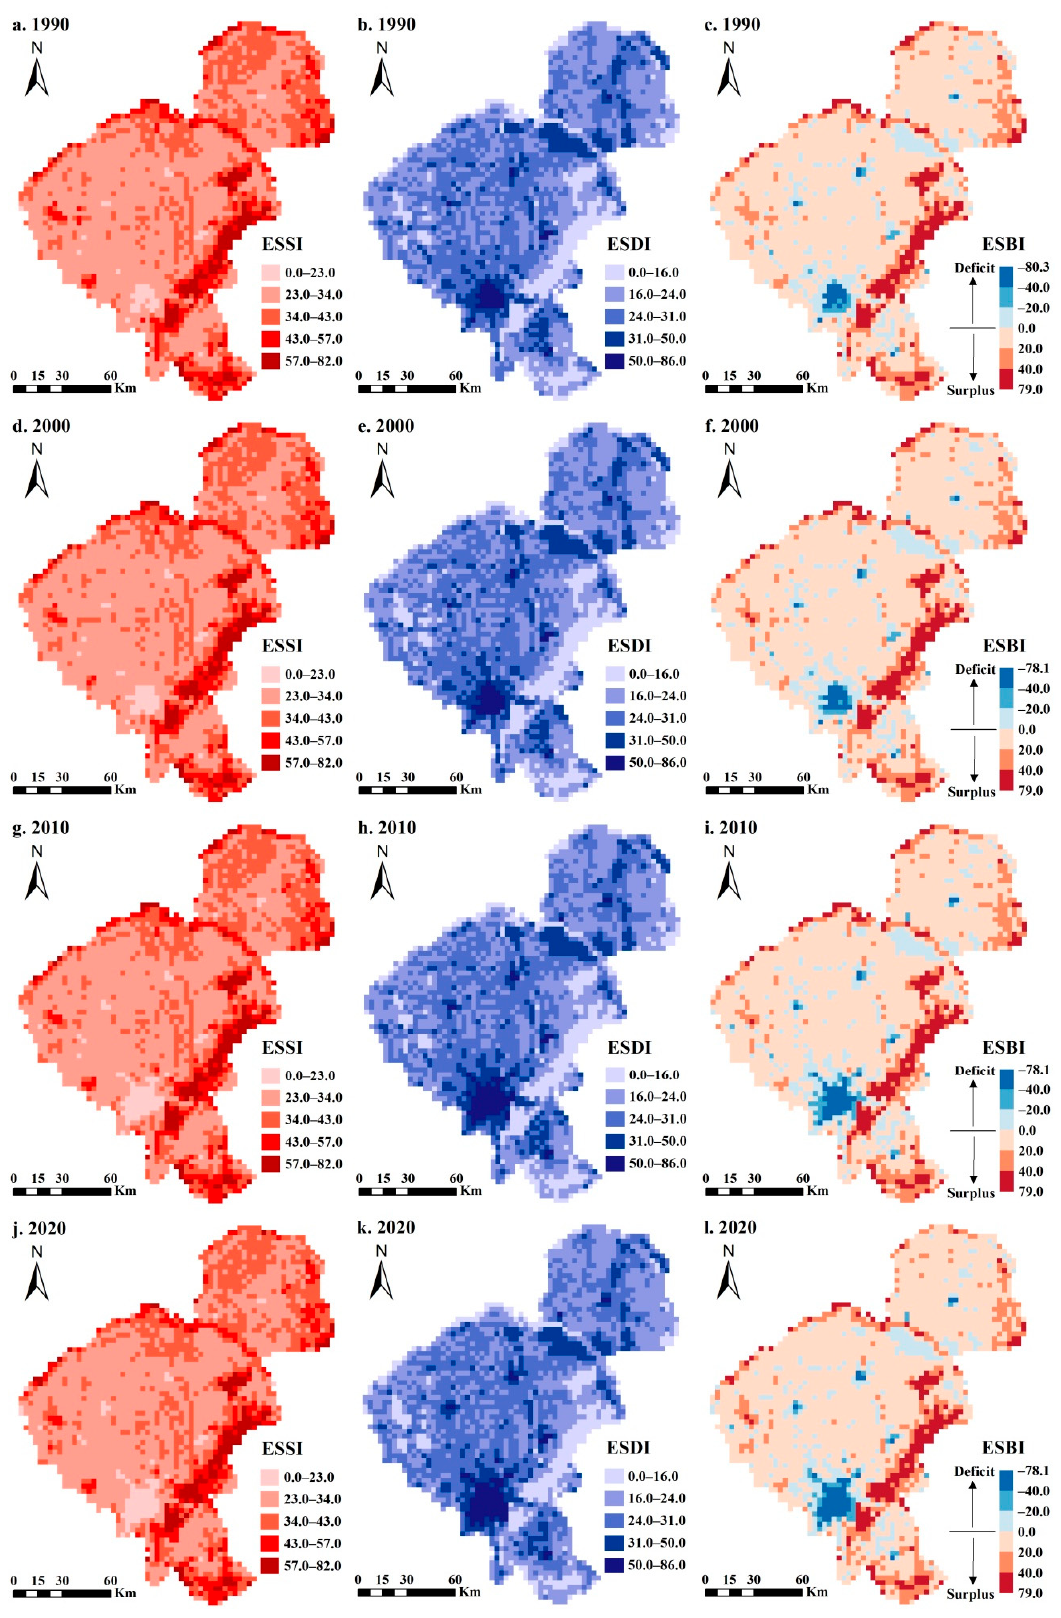
Figure 5. ( a – l ) Spatial distributions of the ESSI, ESDI, and ESBI in Changchun City from 1990 to 2020.